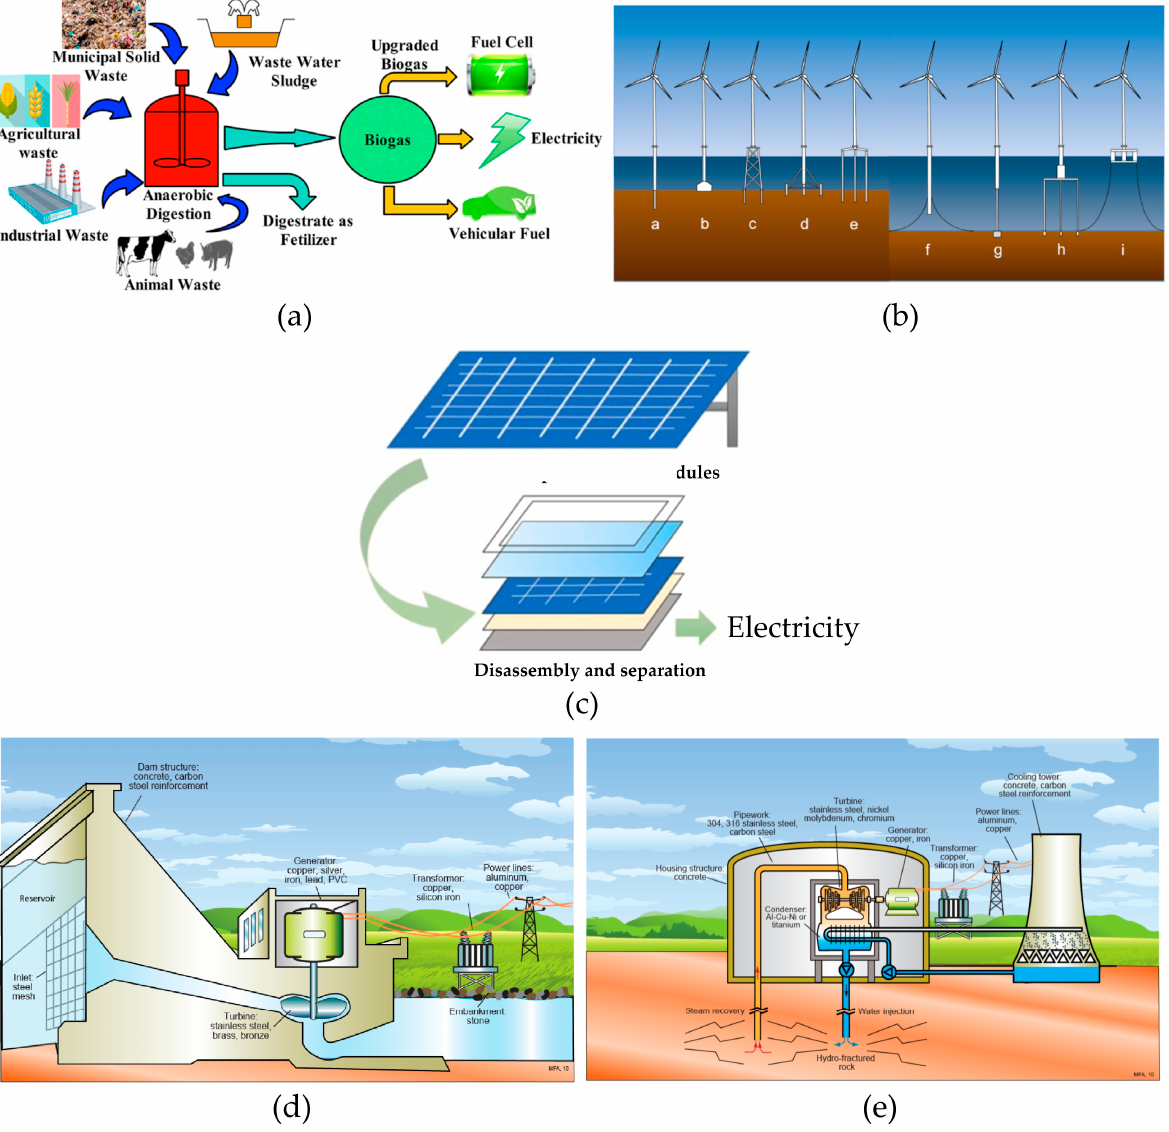
Figure 2. Sources of the electricity: ( a ) biogas, ( b ) wind (a—monopile; b—gravity-based; c—jacket; d—tripod; e—tripole; f—spar type; g and h tension-legged; i semi-submersible), ( c ) photovoltaics, ( d ) hydrology and ( e ) geothermal. Prepared with permissions from [22] (Copyright © 2020 Hydrogen Energy Publications LLC. Published by Elsevier Ltd.), Ref. [23] (Copyright © 2021 Elsevier Ltd.), Ref. [24] (Copyright © 2022 Elsevier Ltd.) and [25] (Copyright © 2013 Elsevier